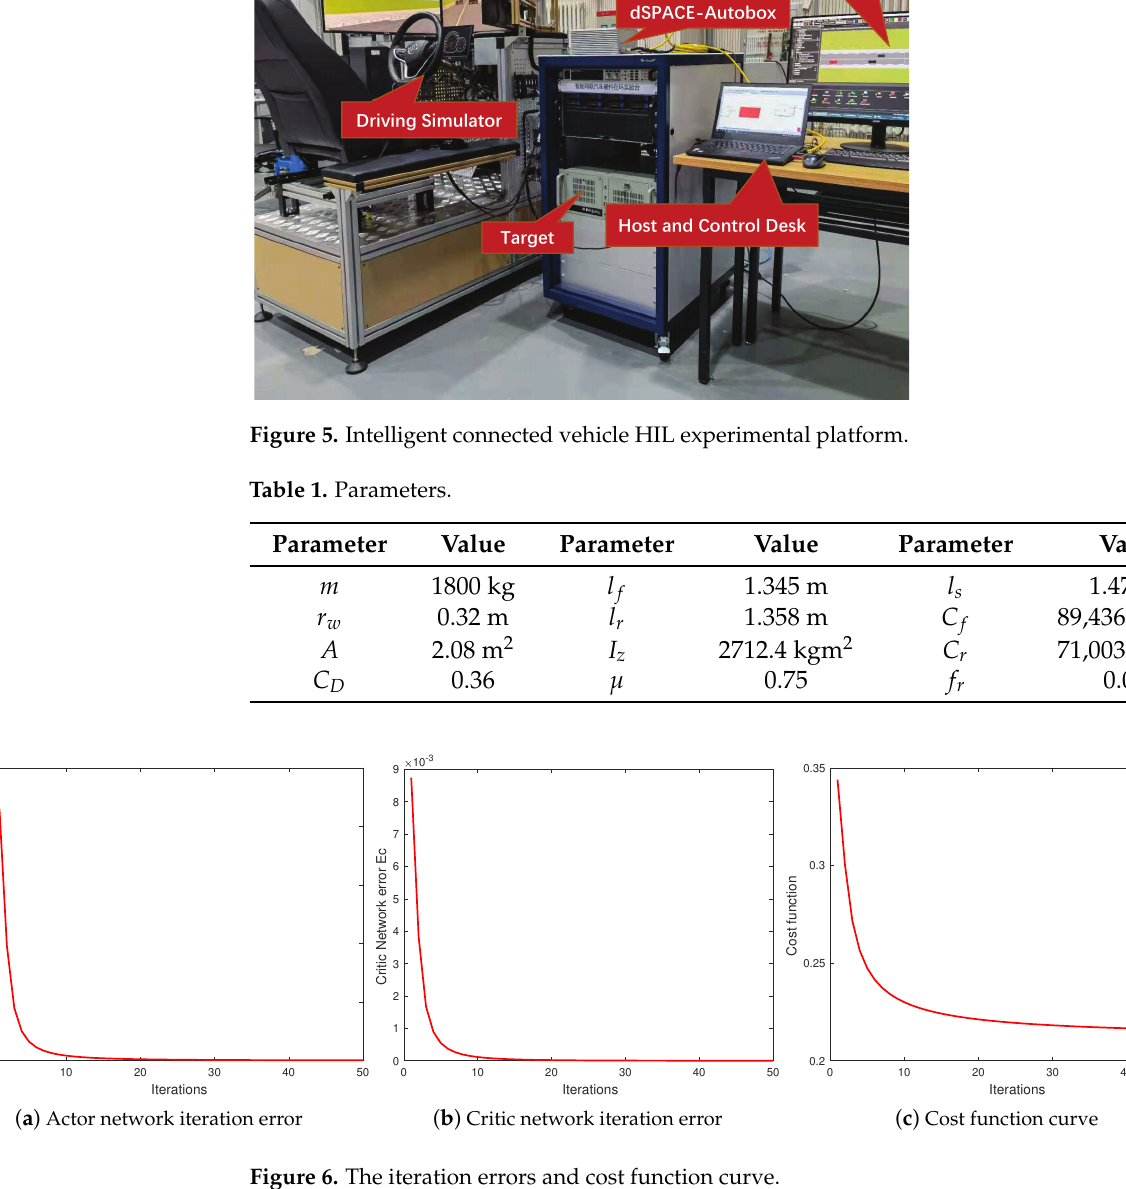
Figure 6. The iteration errors and cost function